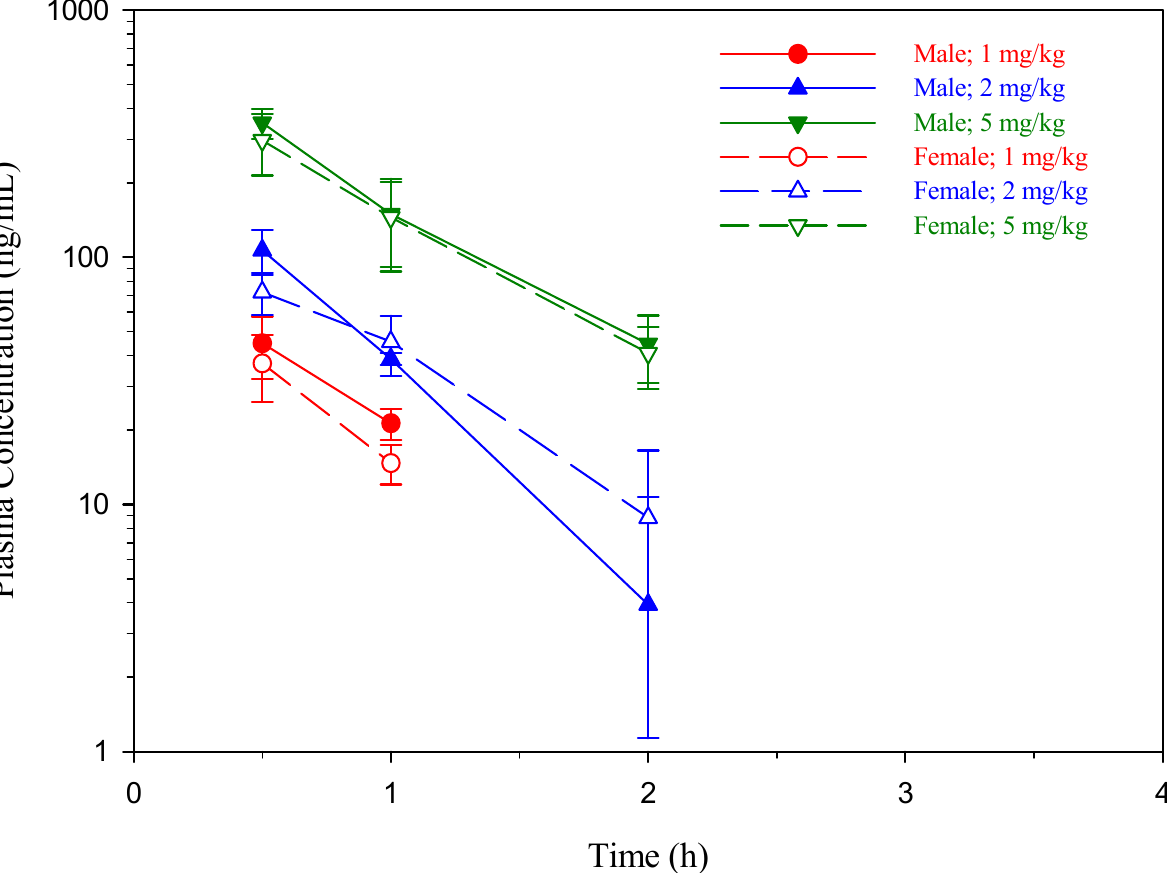
Figure 1. Mean Plasma Concentration-Time Profiles of BMEDA in Beagle Dogs after Intravenous Injection of BMEDA at 1, 2 and 5 mg/kg. Data are expressed as mean ± standard